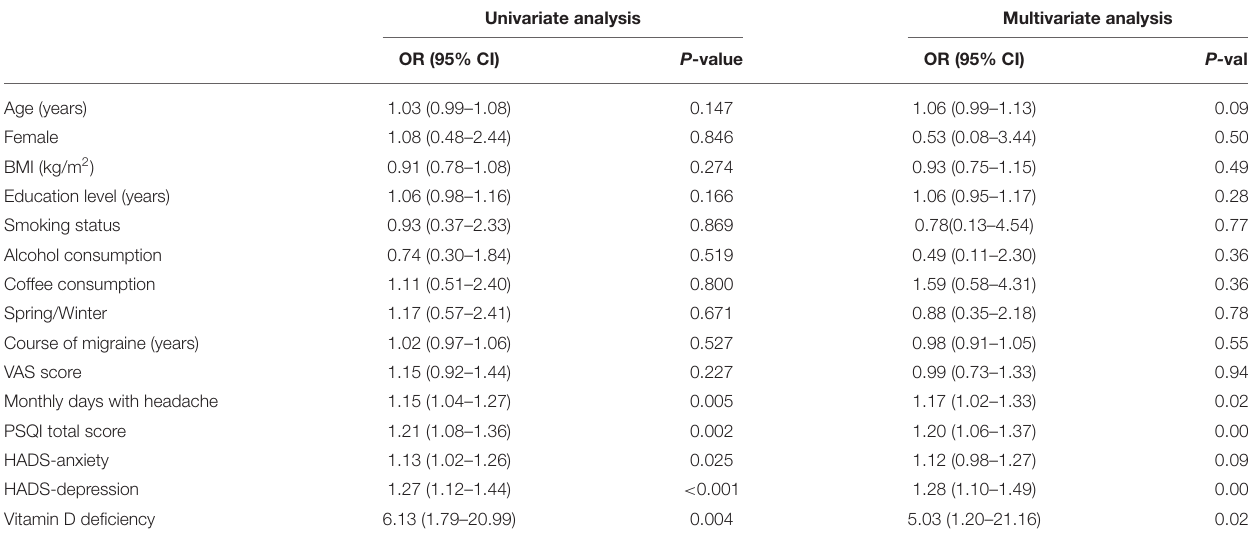
TABLE 5 | Risk factors of RLS in migraine patients with logistic regression